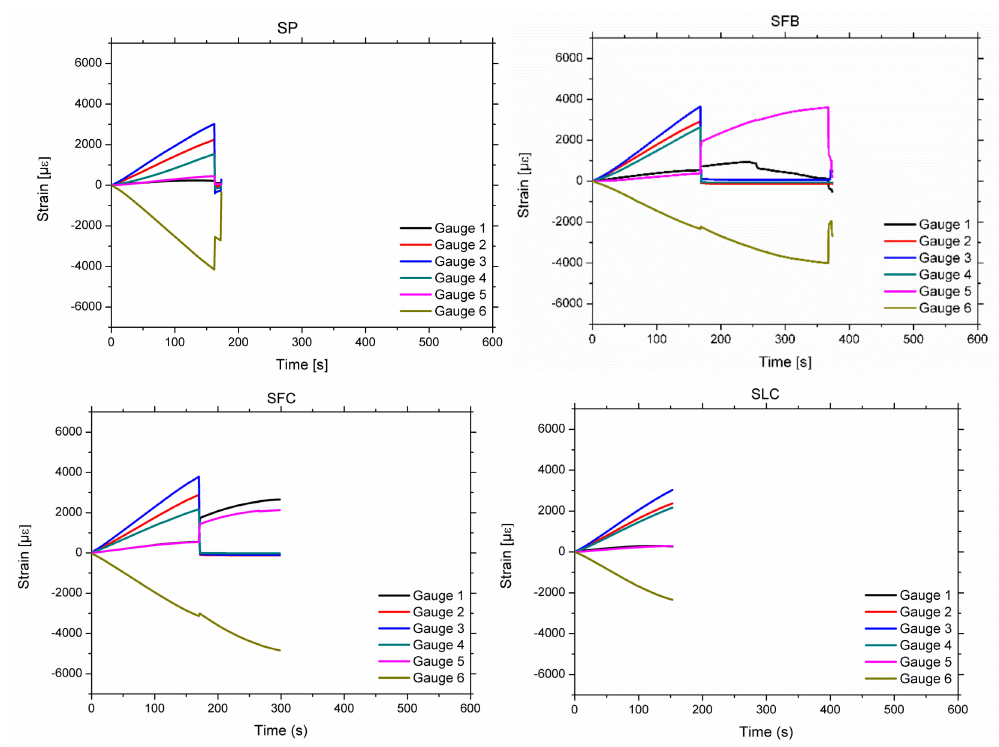
Figure 6. Experimental strain-time plots for all the specimens. See [17] for the position of the strain